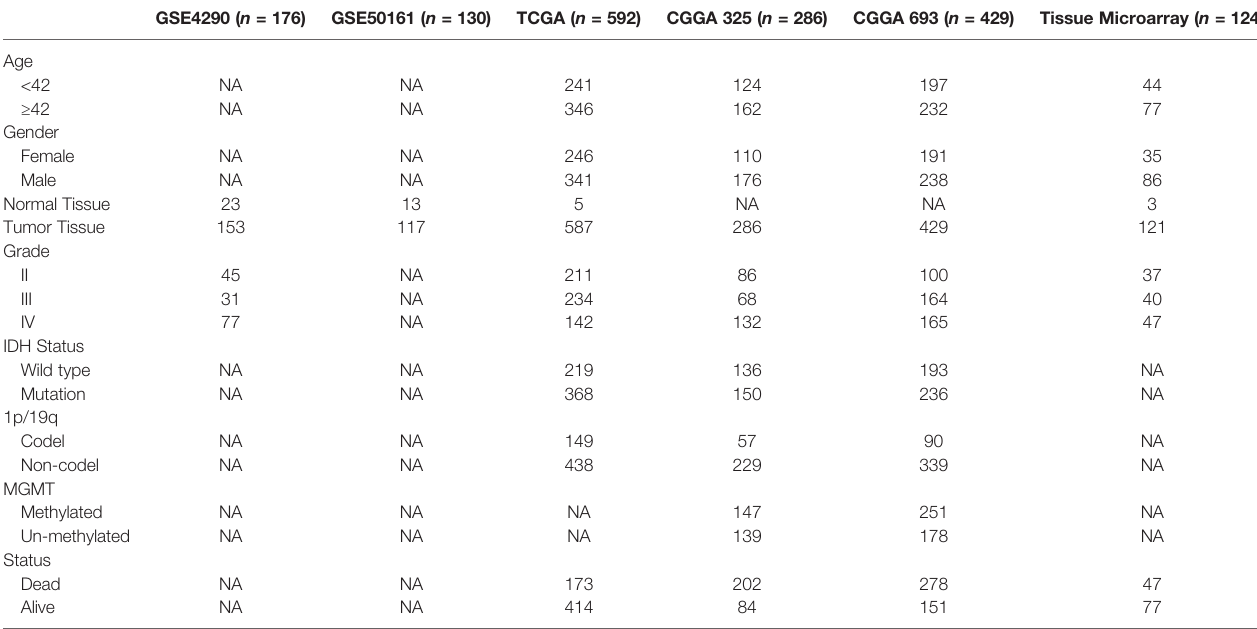
TABLE 1 | Clinicopathological characteristics of glioma patients from the GEO, TCGA, and CGGA database and tissue